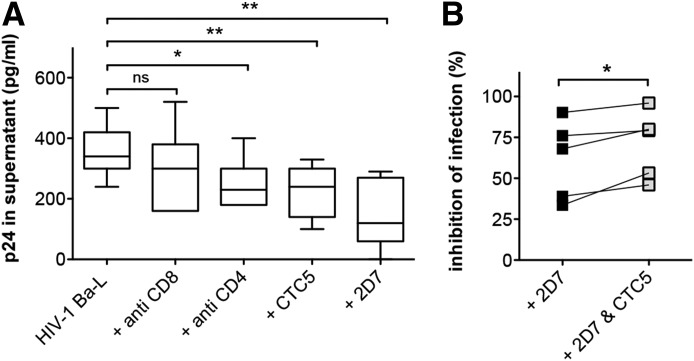
Effect of the CTC5 mAb on HIV-1 replication in MDMs. (A) MDMs, untreated or pretreated with the indicated antibodies at 12.5 µg/ml, were infected with HIV-1Ba-L as described in Material and Methods. The viral production was assessed after a single-round infection, and the box and whiskers plot shows the amount of HIV-1 p24 released in culture supernatants (N = 7); ns, not significant. (B) Similar single-round infections showing a cooperative effect of CTC5 and 2D7 on MDMs. The graph presents the inhibition of infection compared with the infection of MDMs not pretreated with antibodies (N = 5). *P ≤ 0.05. **P ≤ 0.01 by paired 2-tailed Student’s t test.